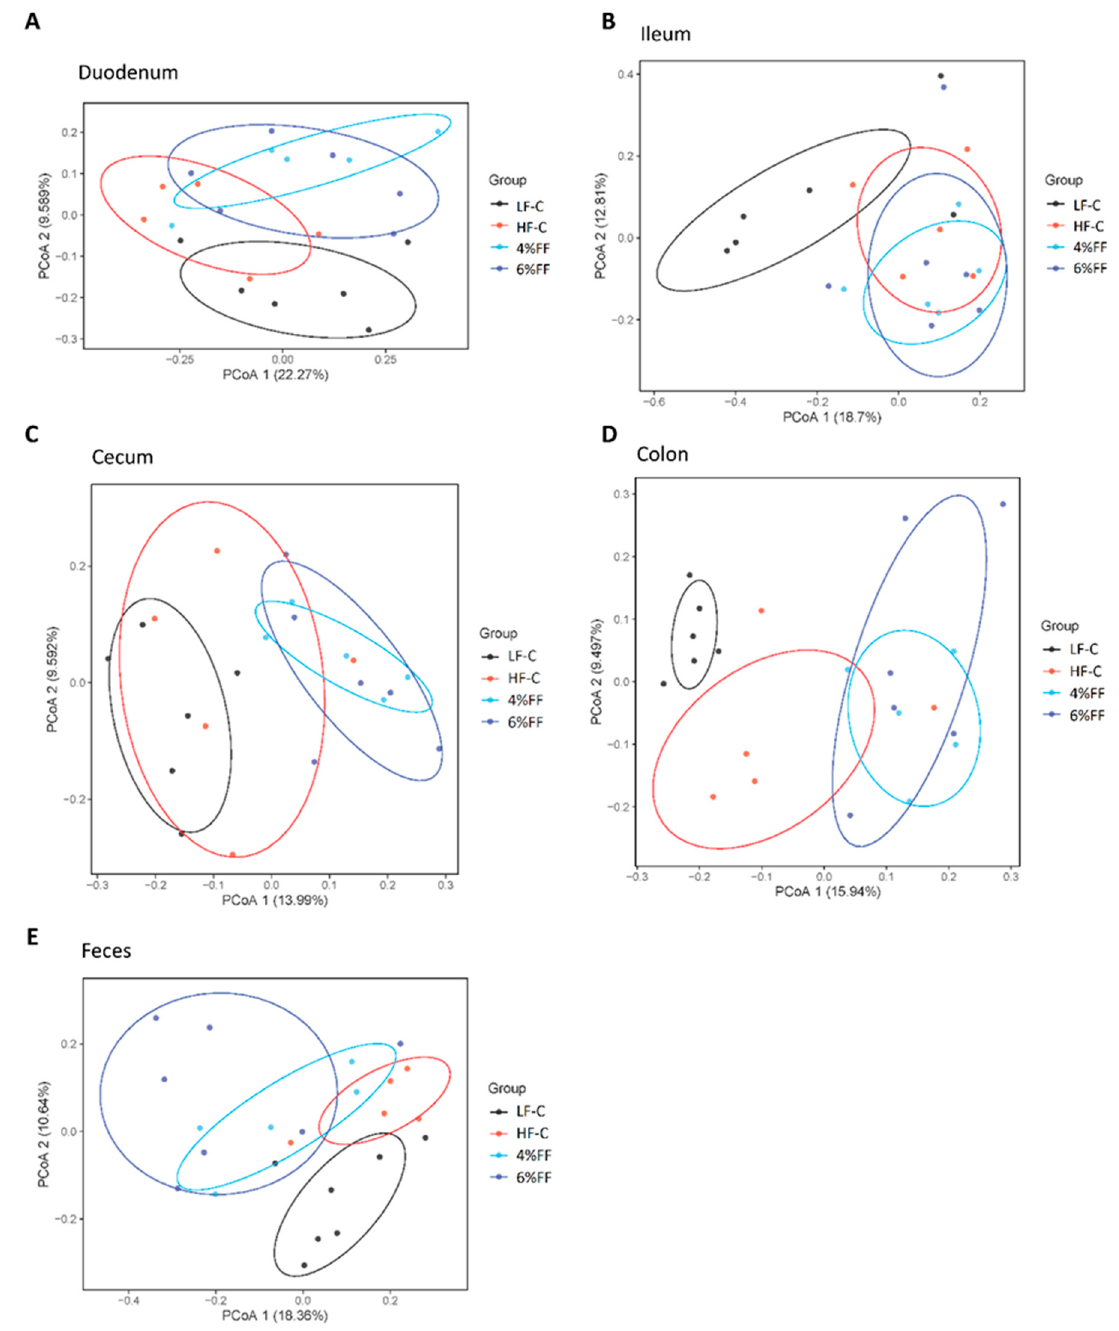
Figure 5. Principal coordinate analysis of different groups in each intestinal segment ( n = 5–7): ( A ) Duodenum, ( B ) Ileum, ( C ) Cecum, ( D ) Colon, and ( E ) Feces.